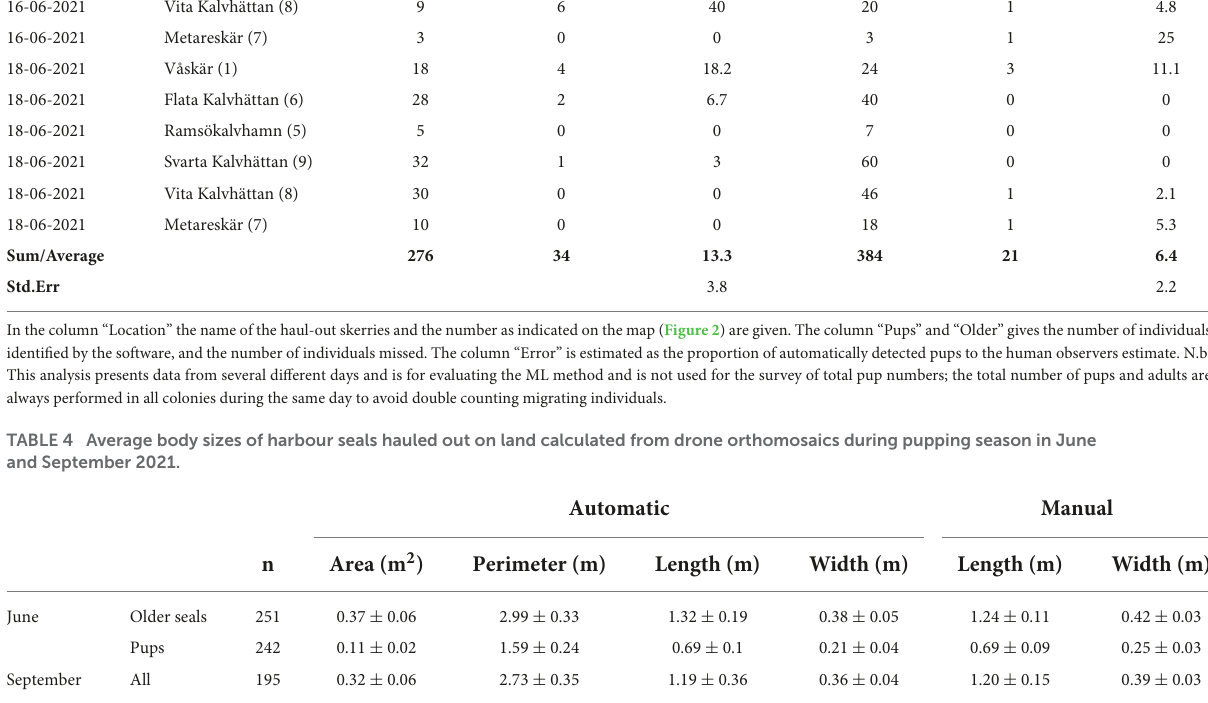
TABLE 3 Number of pups and older seals identified with machine learning and validated with manual inspection of the digital photos. Pups Older seals